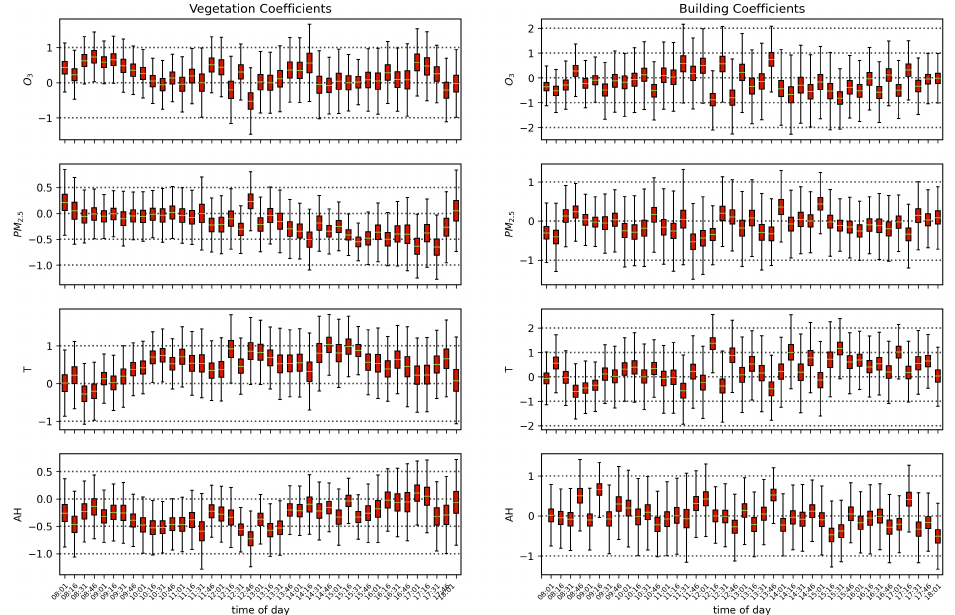
Figure 15. The coefficients for models containing all air quality parameters: O 3 , PM 2.5 , temperature, and absolute humidity, for each series of standardized time-of-day Solar-Induced Fluorescence indicator ( SIFi ) for vegetation ( left ) and buildings ( right